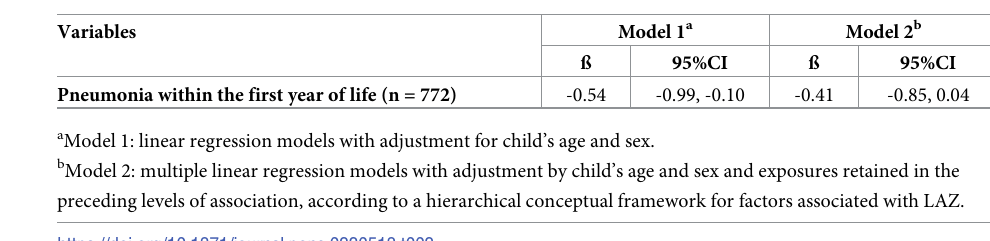
preceding levels of association, according to a hierarchical conceptual framework for factors associated with